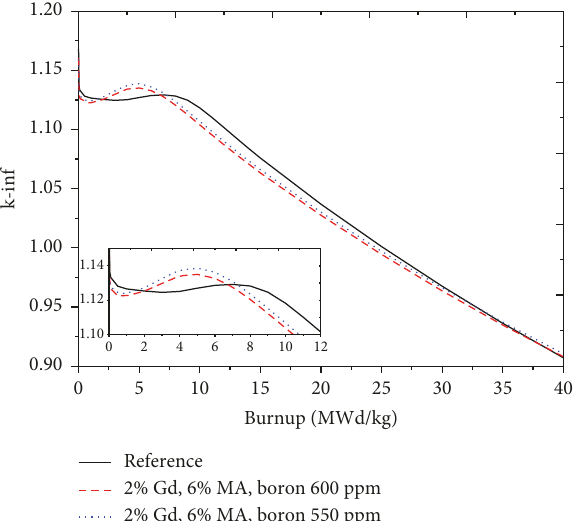
Figure 6: The k-inf versus burnup when loading 10 wt.% of MAs and reducing GD to 2wt.%.